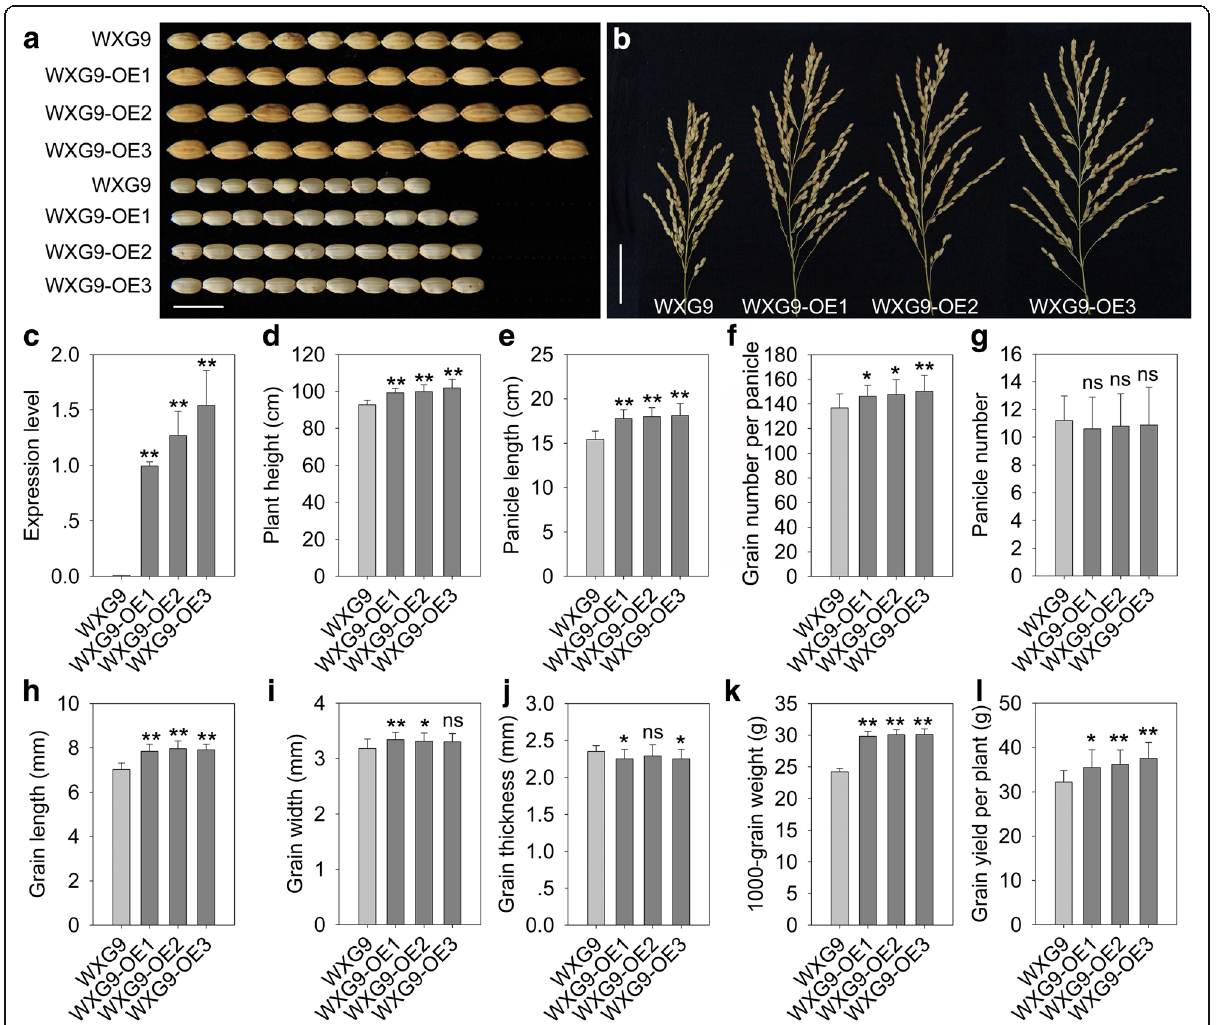
Fig. 4 Overexpression of qPE9 – 1 in high-yield rice Wuxianggeng 9 affected multiple agronomic traits. a Grains and brown rice of WXG9 and three overexpressing lines, WXG9-OE1, WXG9-OE2, and WXG9-OE3. Bar=1cm. b Panicles of WXG9 and three overexpressing transgenic lines. Bar=5cm. c-l Comparisons of qPE9 – 1 expression level (c), plant height (d), panicle length (e), grain number per panicle (f), panicle number per plant (g), grain length (h), grain width (i), grain thickness (j), 1000-grain weight (k), and grain yield per plant (l), between WXG9 and three overexpressing lines. Data are shown as means ± SDs (n=15). Student ’ s t -test: * P <0.05; ** P <0.01; ns, not